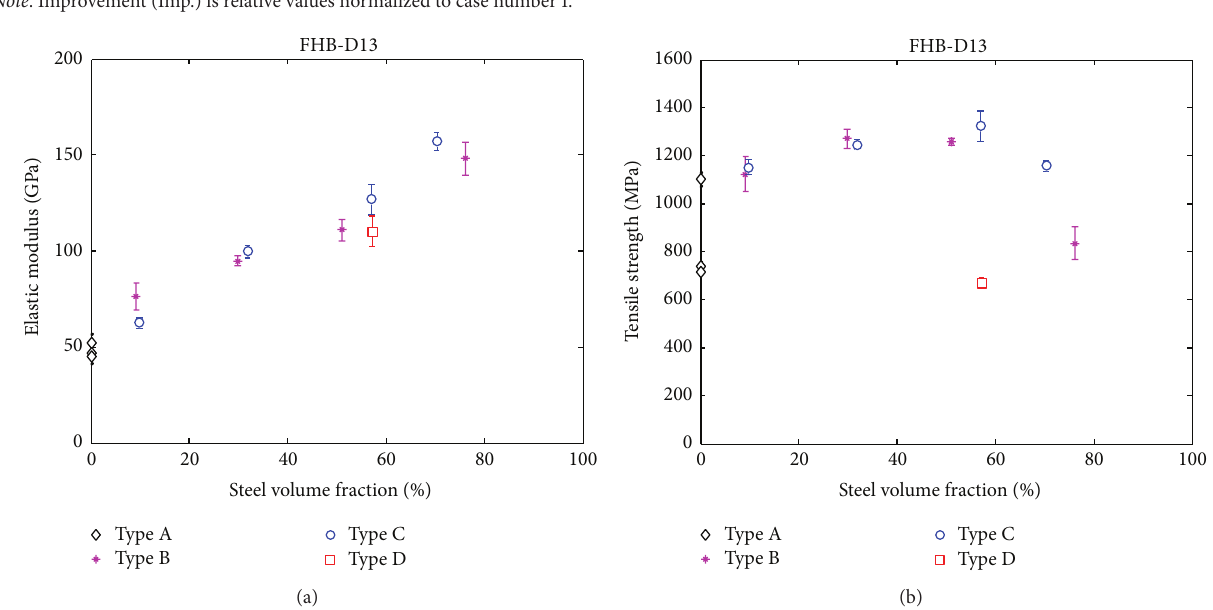
Figure 13: Test results for D13 FRP Hybrid Bar: (a) elastic modulus; (b) tensile strength.